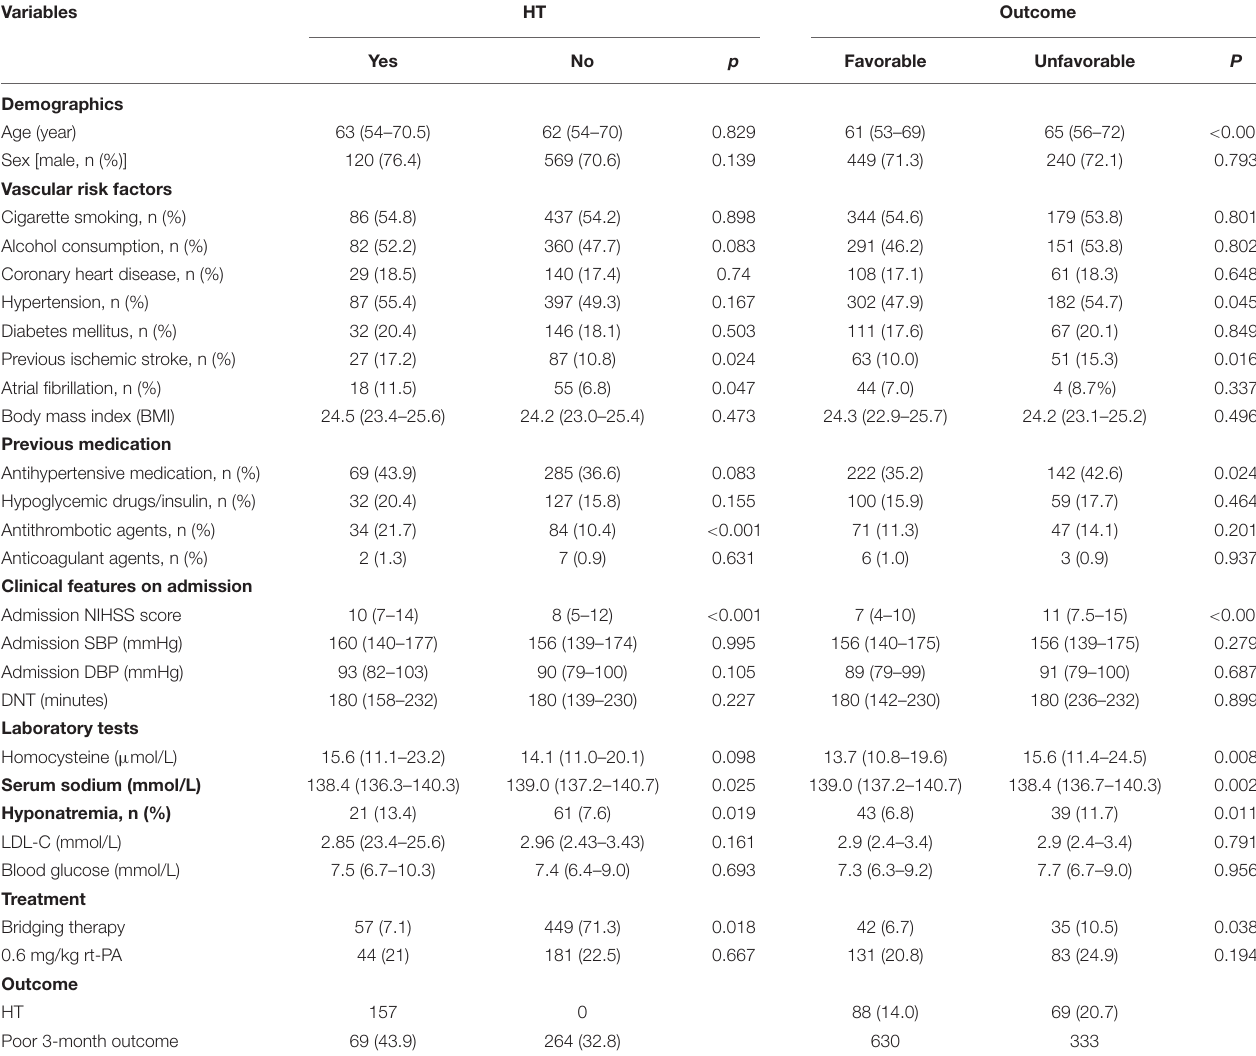
TABLE 2 | Univariate analysis of the baseline factors associated with HT and 3-month outcomes.